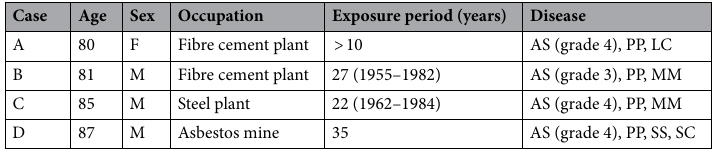
Table 1. Samples’ description. AS asbestosis (grading established according to Craighead et al . 1982 36 , PP